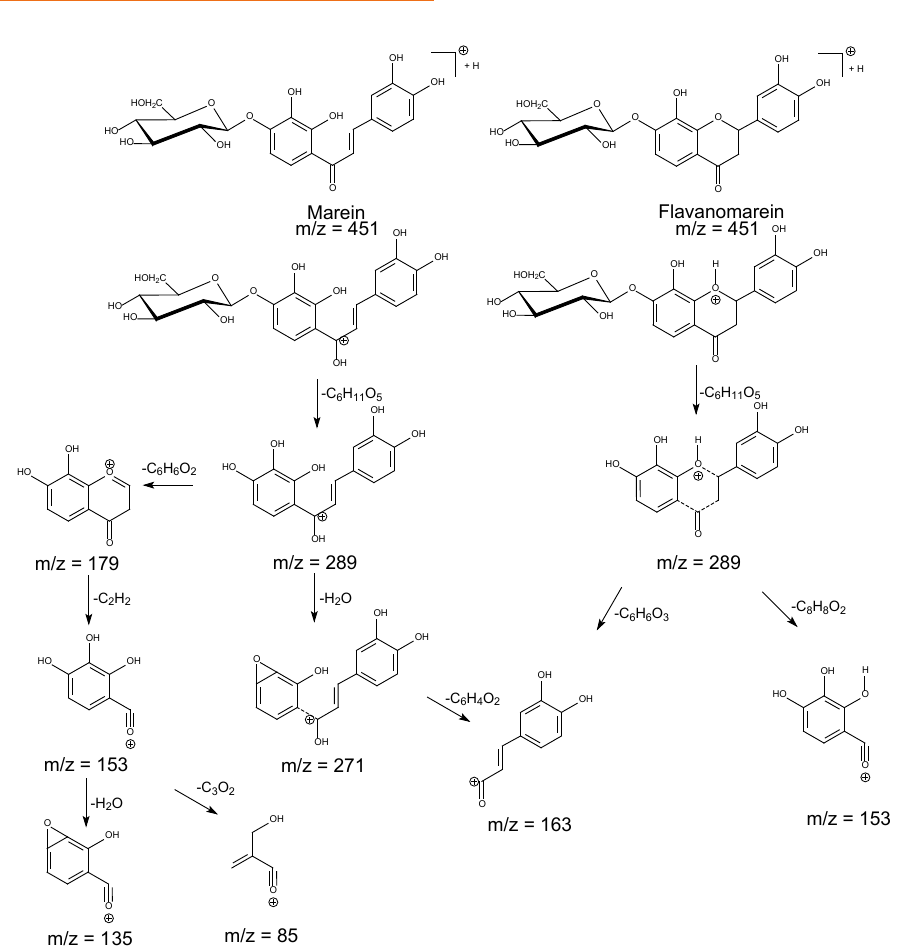
Scheme 1. Proposed fragmentation pathway of flavanomarein ( 2 ) and marein ( 3